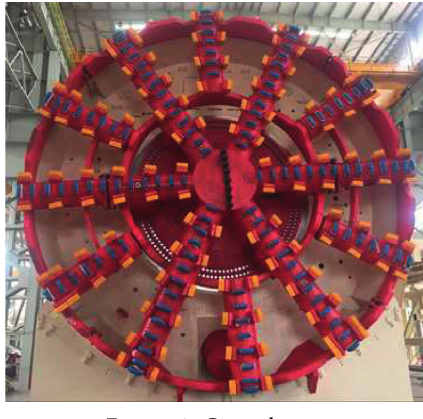
Figure 2: Cutter layout. Table 1: Specification of operated